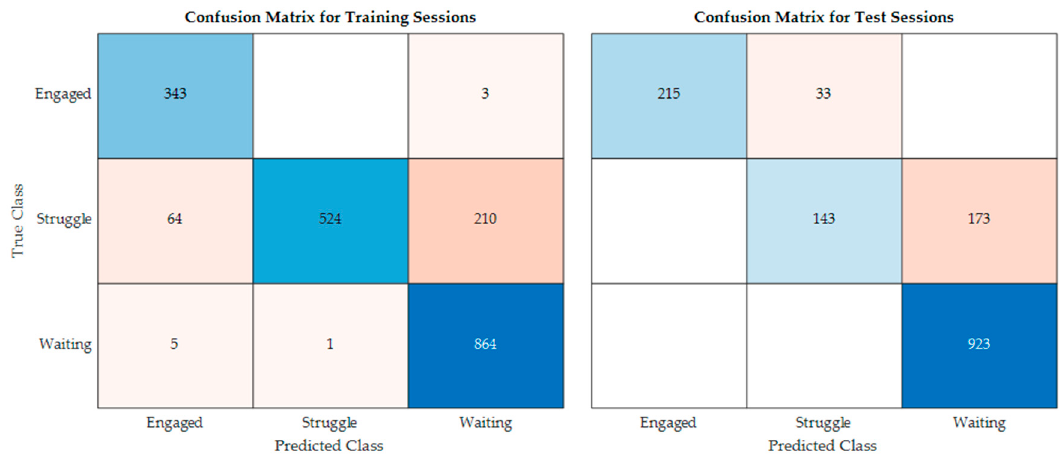
Figure 6. Confusion matrices.